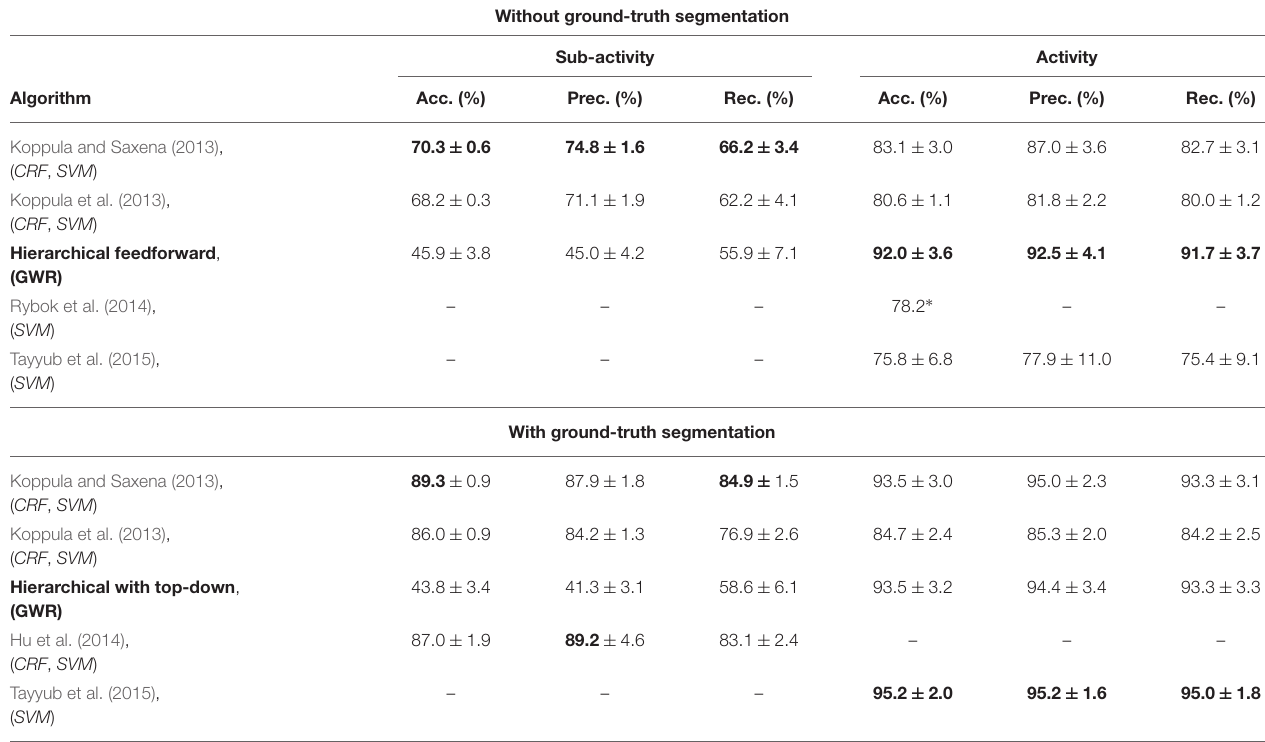
TABLE 1 | Classification results on the action hierarchy of the CAD-120 dataset (Mici,